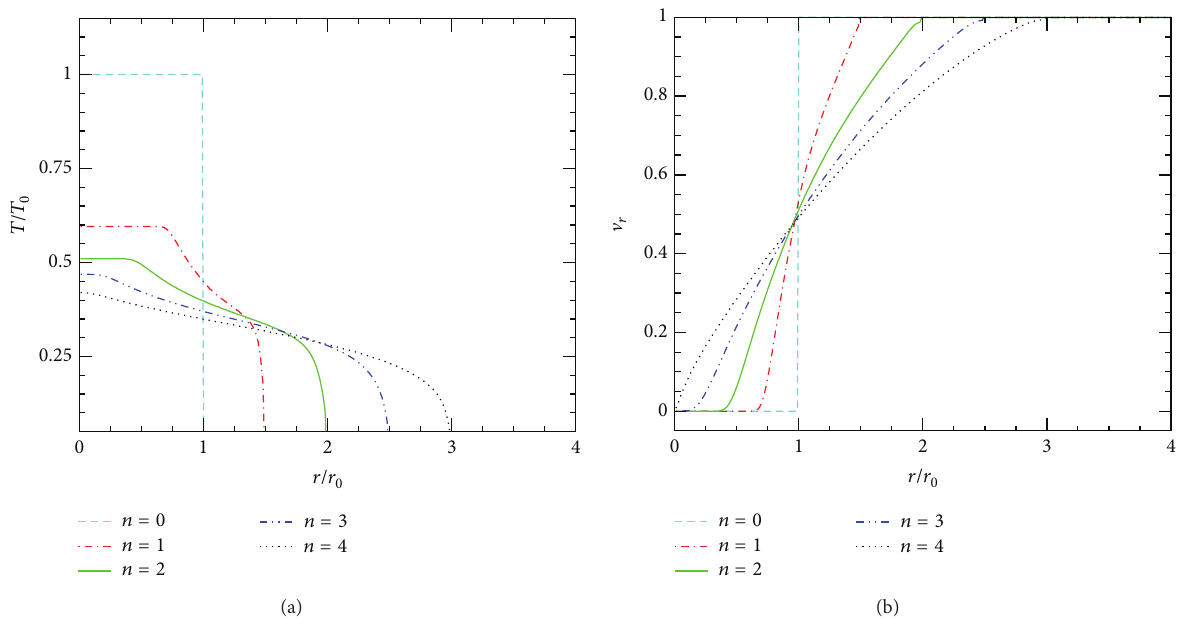
Figure 4: The profiles of temperature (a) and transverse velocity (b) for the expanding QGP system with Bjorken cylinder at different time ( 𝑡 𝑛 = 𝜏 0 + 0.5𝑛𝜆𝑟 0 , 𝜆 = 0.99 ) (color